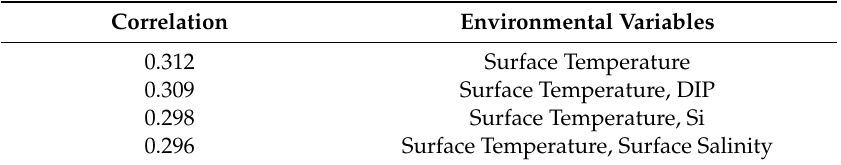
Table 3. Multivariate correlation of Thalassiosira species composition with environmental